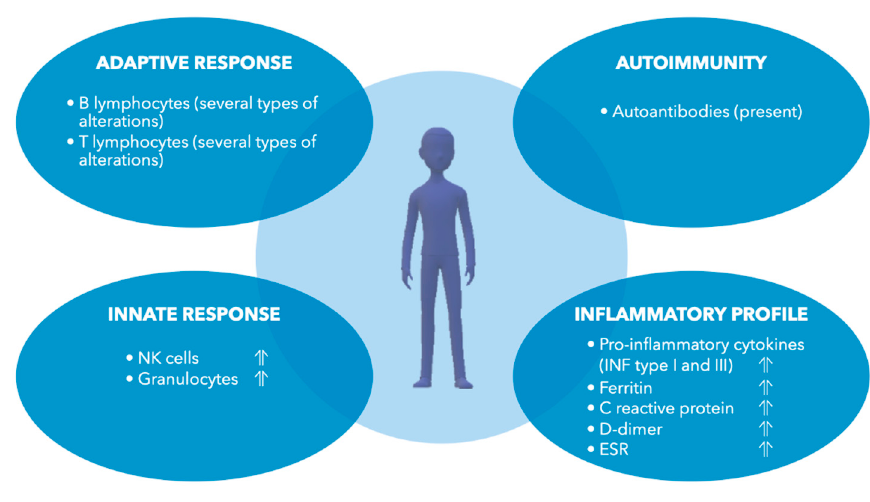
Figure 2. Immunological and inflammatory alterations described in long COVID-19.